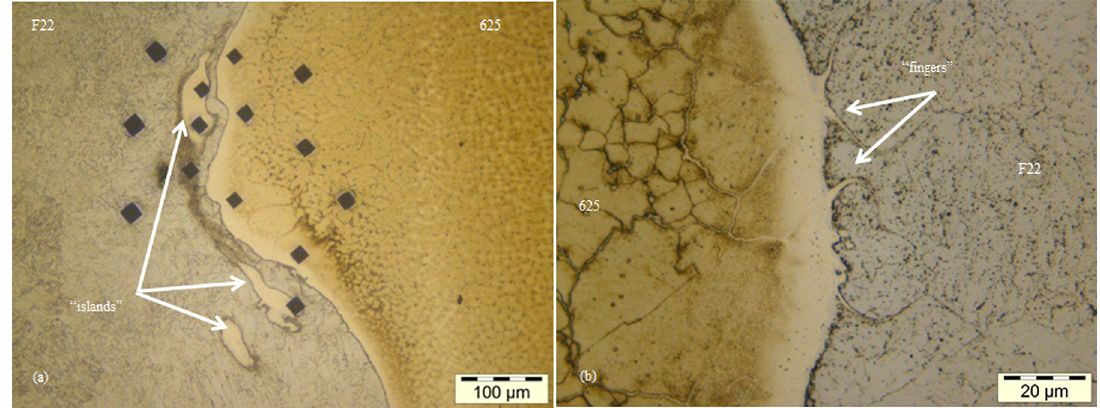
Figure 8. LAMS optical microscopy of buttering weld after PWHT. (a) "Islands " (200x). (b) "fingers" (1000x).